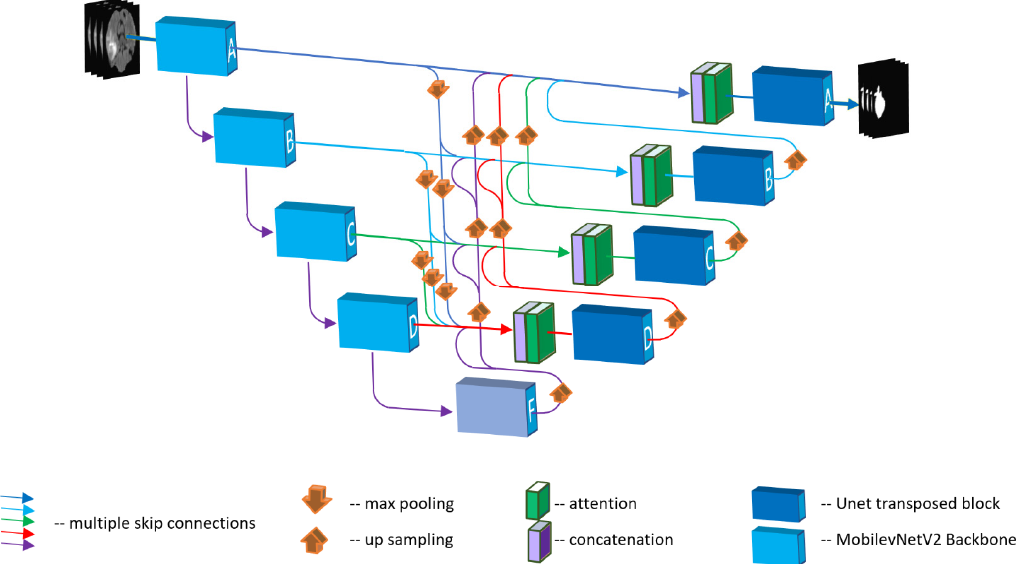
Figure 1. Block diagram of the architecture of our proposed model; MobileNetV2 backbone is used as an encoder. Transposed convolution is performed for up-sampling between levels.